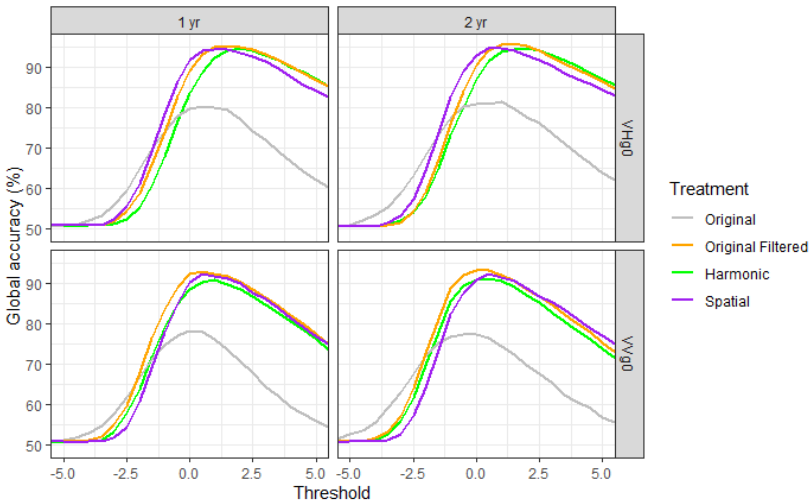
Figure 12. Global accuracy of the adaptive linear thresholding detection procedure. Remote Sens. 2020 , 12 , x FOR PEER REVIEW